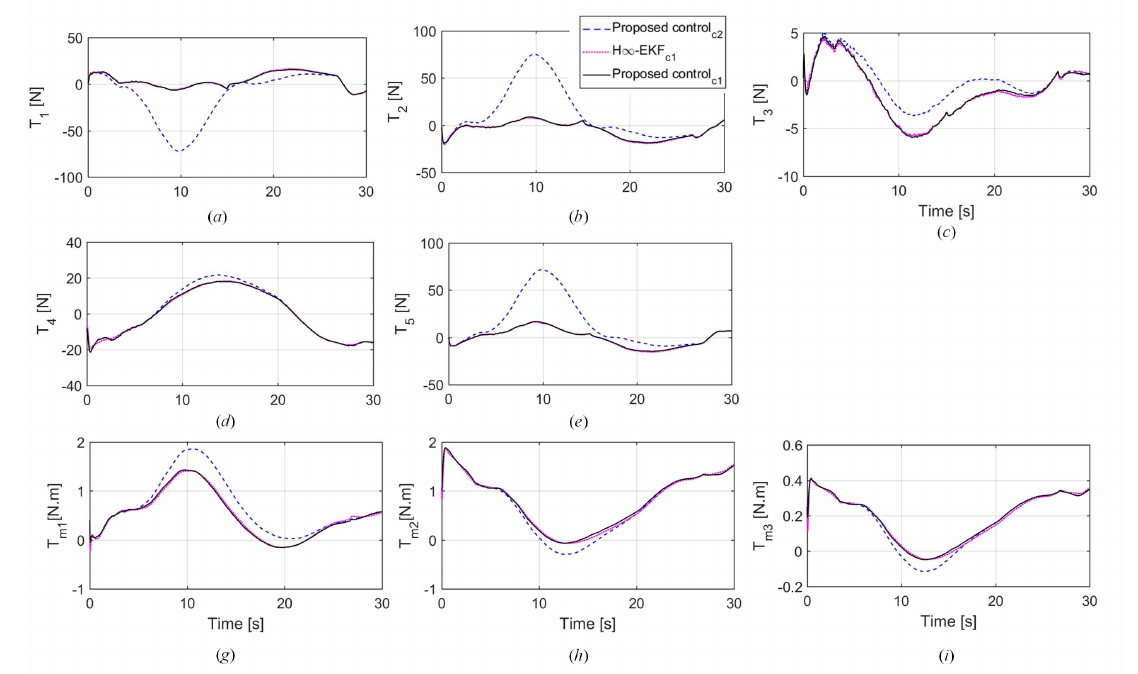
Figure 12. Thruster forces and actuator torques for the line trajectory tracking. ( a – e ) Thruster forces T 1 , T 2 , T 3 , T 4 and T 5 ; ( g – i ) actuator torques T m 1 , T m 2 and T m 3 .